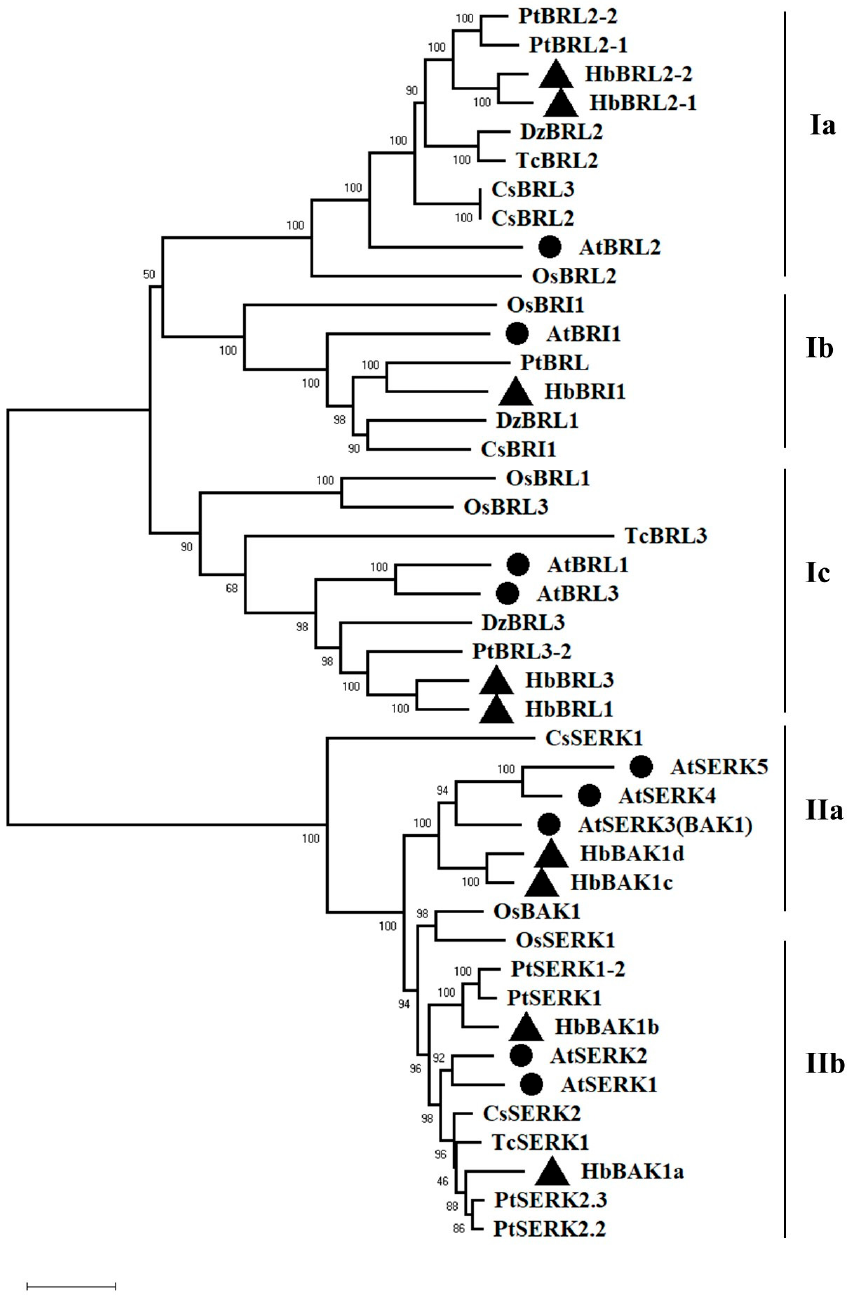
Figure 1. The phylogenetic tree of BRI1 and BAK1 proteins in Arabidopsis , rice, durian, aspen, cacao, orange and rubber tree. Phylogenetic relationships between 47 proteins in these 7 species. A neighbor-joining tree was created by using MEGA X (1000 replicates), and the bootstrap value of each branch is displayed. At: Arabidopsis thaliana , Os: Oryza sativa , Dz: Durio zibethinus , Pt: Populus trichocarpa , Tc: Therobroma cacao , Cs: Citrus sinensis , Hb: Hevea brasiliensis . Black circles represent genes in Arabidopsis ; black triangles represent genes in the rubber tree. Scale bar shows 0.1 amino acid substitutions per